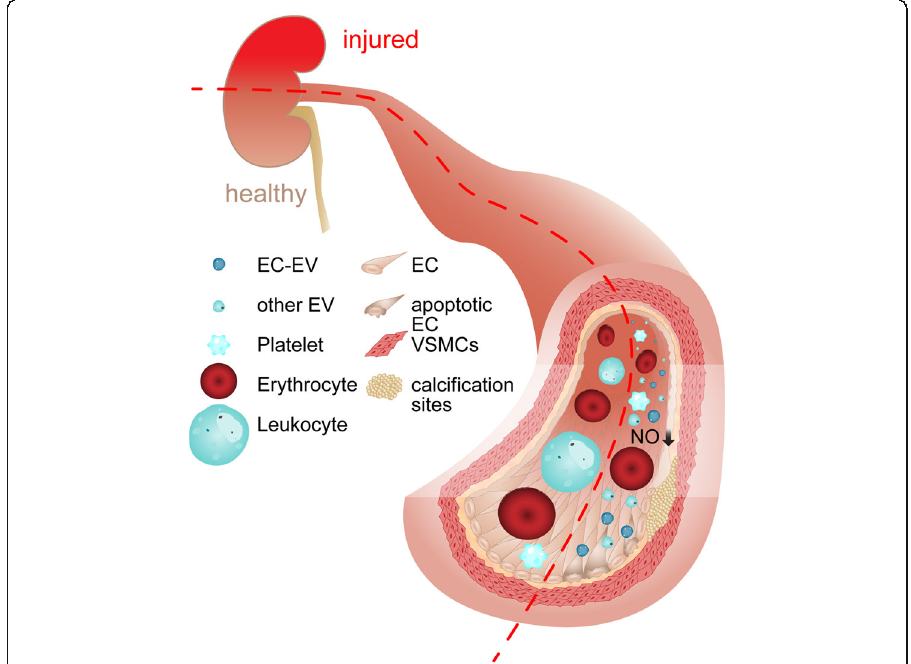
Fig. 3 Vascular effects of circulating EVs from patients with kidney injury. Blood EVs from patients with CKD convey pathologic effects on the vessel wall compared to EVs from healthy donors in vitro. These include increased endothelial apoptosis, reduced angiogenesis (not displayed), vascular calcification by VSMC osteochondrogenic differentiation and reduced endothelial NO production as a marker for endothelial dysfunction. The concentration of EC-EVs in patient samples revealed a positive correlation with these effects, pointing towards a potential